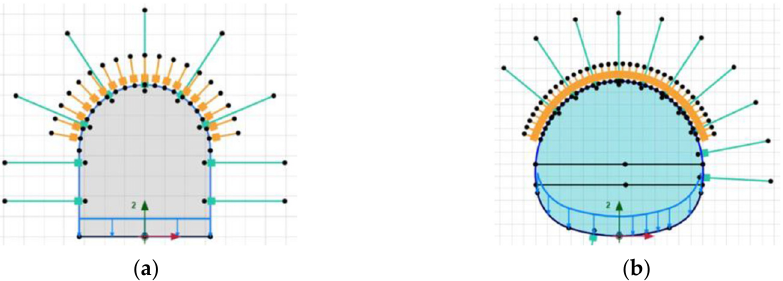
Figure 7. A cross section of a tunnel with rock bolts and pipe roofings: ( a ) the pilot tunnel and ( b ) the eastbound tunnel.